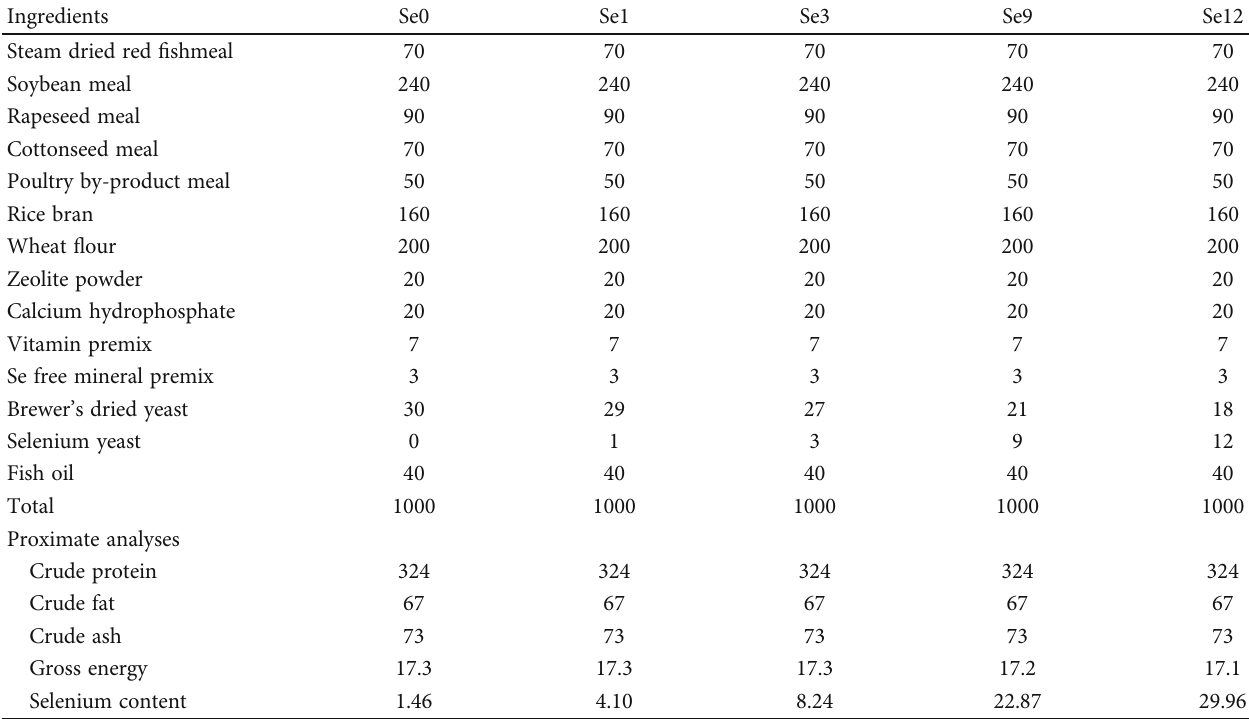
Table 1: Formulation (g/kg), proximate composition (g/kg), contents of energy (MJ/kg), and selenium (mg/kg) in the test diets. Ingredients